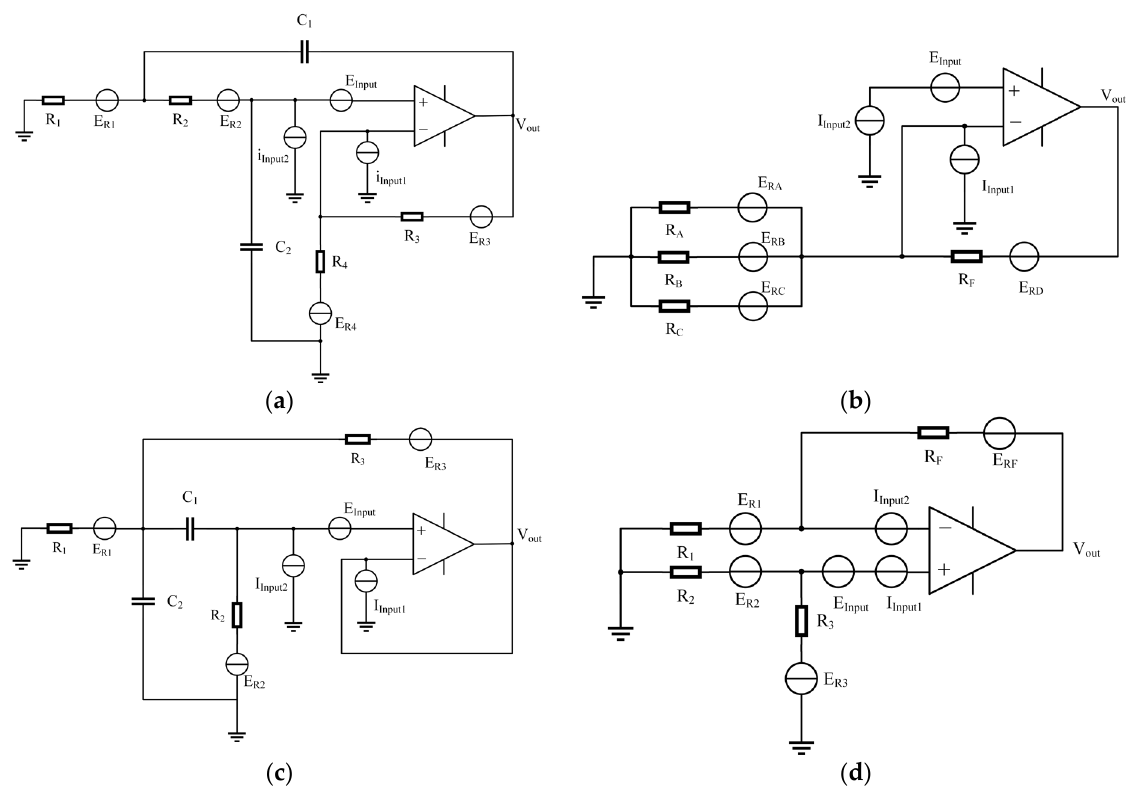
Figure 11. ( a ) Lowpass circuit noise equivalent model; ( b ) adding circuit noise equivalent model; ( c ) noise model of the bandpass filter circuit; ( d ) subtraction circuit noise model.